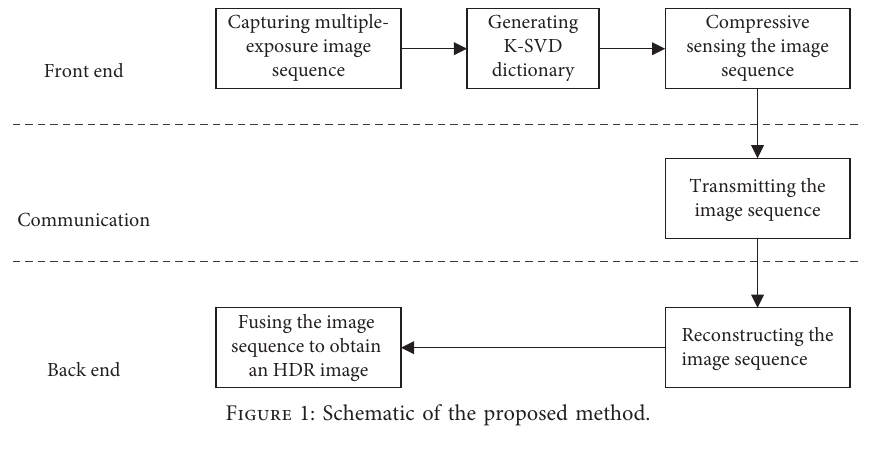
Figure 1: Schematic of the proposed method.